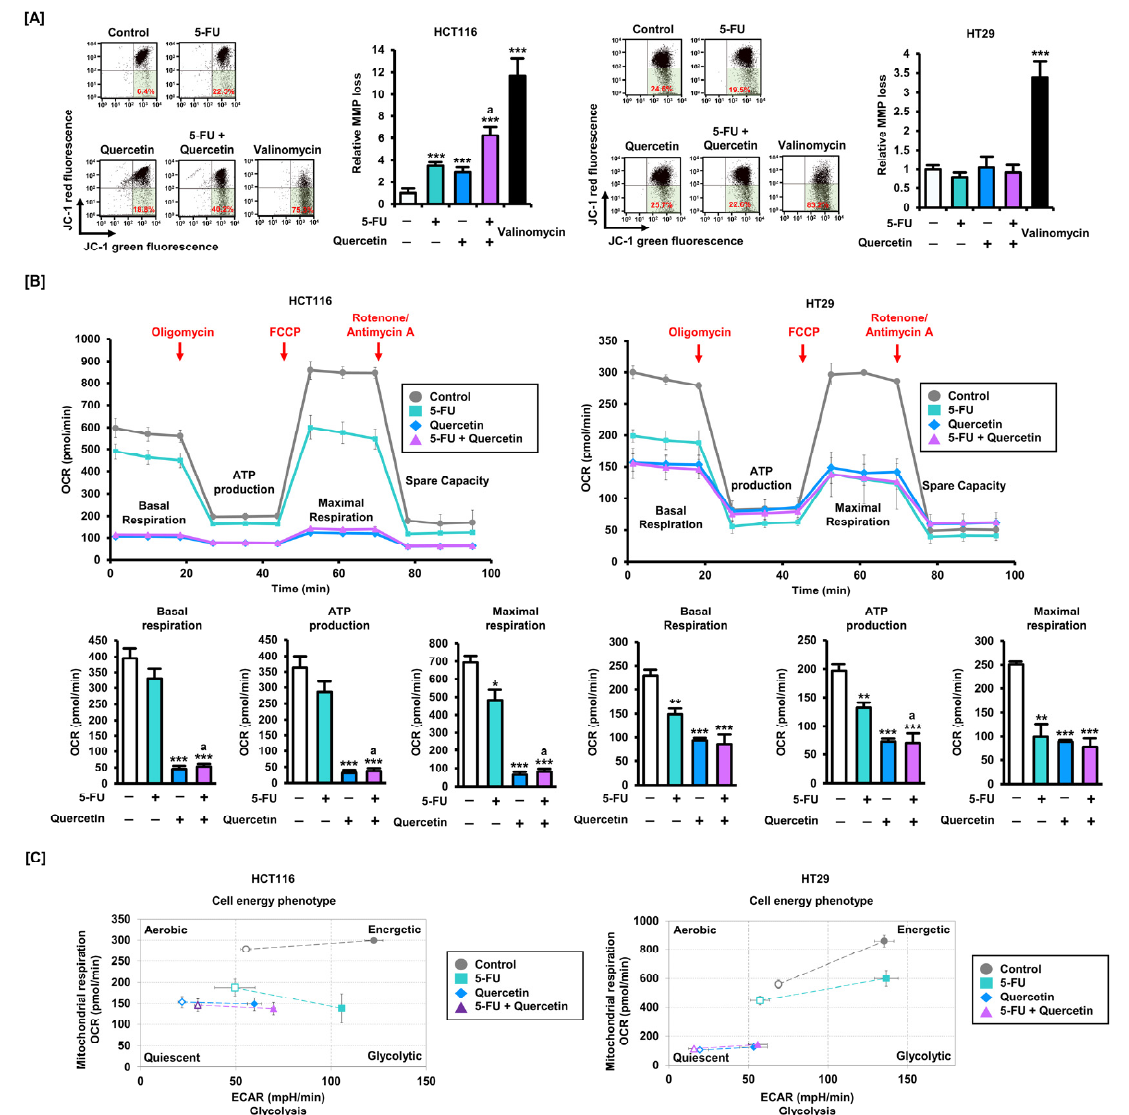
Figure 4. Quercetin induces mitochondrial dysfunction in CRC cells. ( A ) Effects of 5-FU (20 μ M) and quercetin (40 μ M) combination treatment on mitochondrial membrane potential (MMP) loss in HCT116 and HT29 cells over 48 h. JC-1 fluorescence values were estimated by flow cytometry. The percentage of cells corresponding to the lower right was used for relative comparisons. ( B ) Mito- chondrial respiration index following the combined treatment of 5-FU (20 μ M) and quercetin (40 μ M) was analyzed by Seahorse assay. ( C ) Changes in cellular energy expression following the com- bined treatment of 5-FU (20 μ M) and quercetin (40 μ M) were indicated. Data are presented as rep- resentatives of the results of three independent experiments. Asterisks indicate statistically signifi- cant differences compared with untreated controls (*** p < 0.001; ** p < 0.01; * p < 0.05). The symbol ‘a’ indicates a significant difference between combination treatment and 5-FU treatment alone ( p < 0.05).